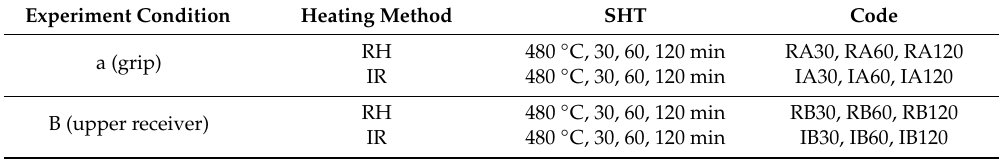
Table 2. Experimental parameters and specimen codes (only solution heat treatment).